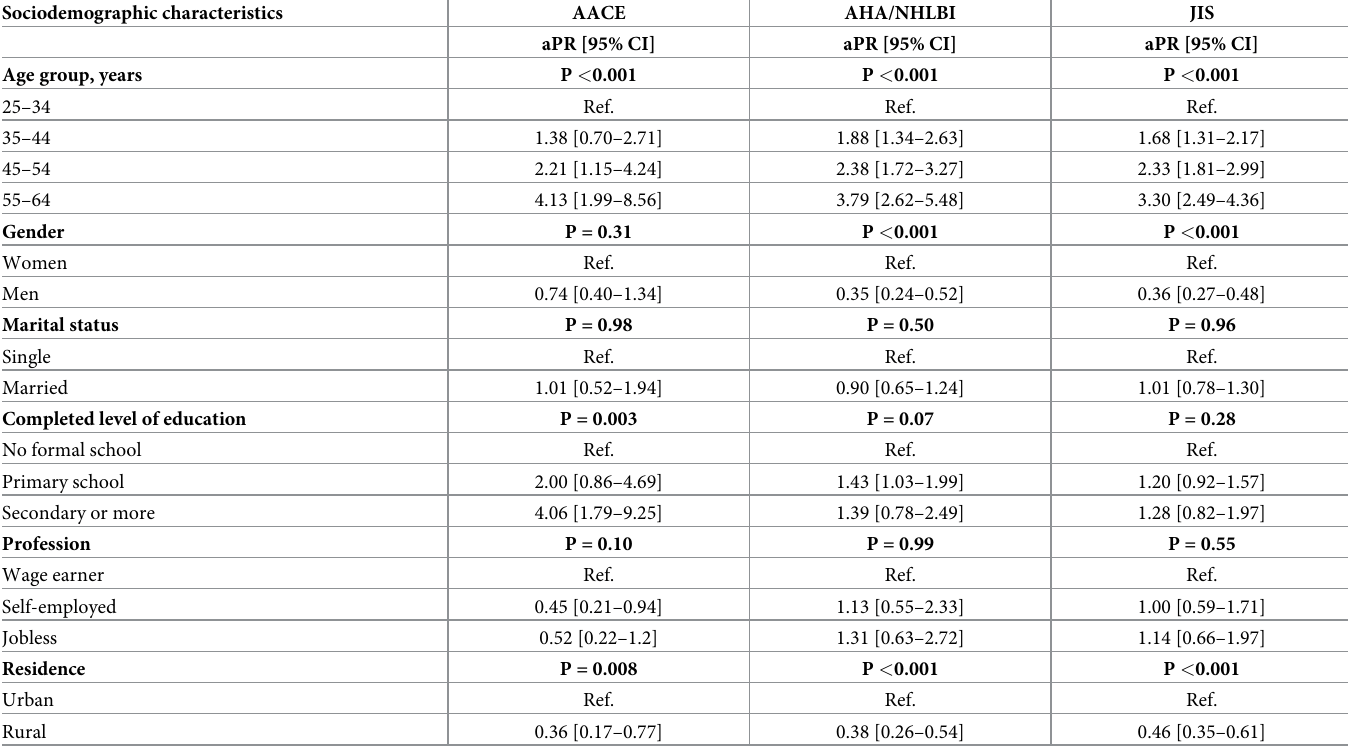
The model was adjusted for all behavioral risk factors in Table 2, ACE: American College of Endocrinology; AHA/NHLBI: American Heart Association and National Heart Lung and Blood Institute; JIS: Joint Interim Statement; CI: confidence interval, aPR: adjusted prevalence